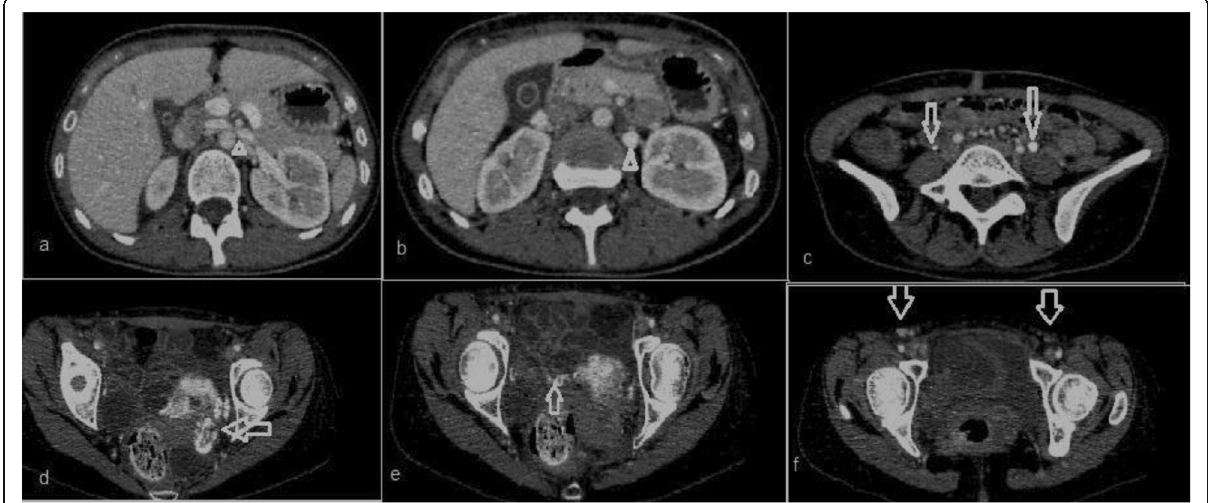
Fig. 10 a CTV axial images showing nutcracker of the pre-aortic left renal vein at b the aorto-mesenteric window (arrow head) showing c left gonadal vein dilatation (arrow head) showing the difference in caliber between the right and d left gonadal veins (open white arrows) showing e left parametrial varices (open white side arrow) showing f crossing parametrial varices (open white arrow) superficial inguinal varicosities seen more on the right side (open white arrows)